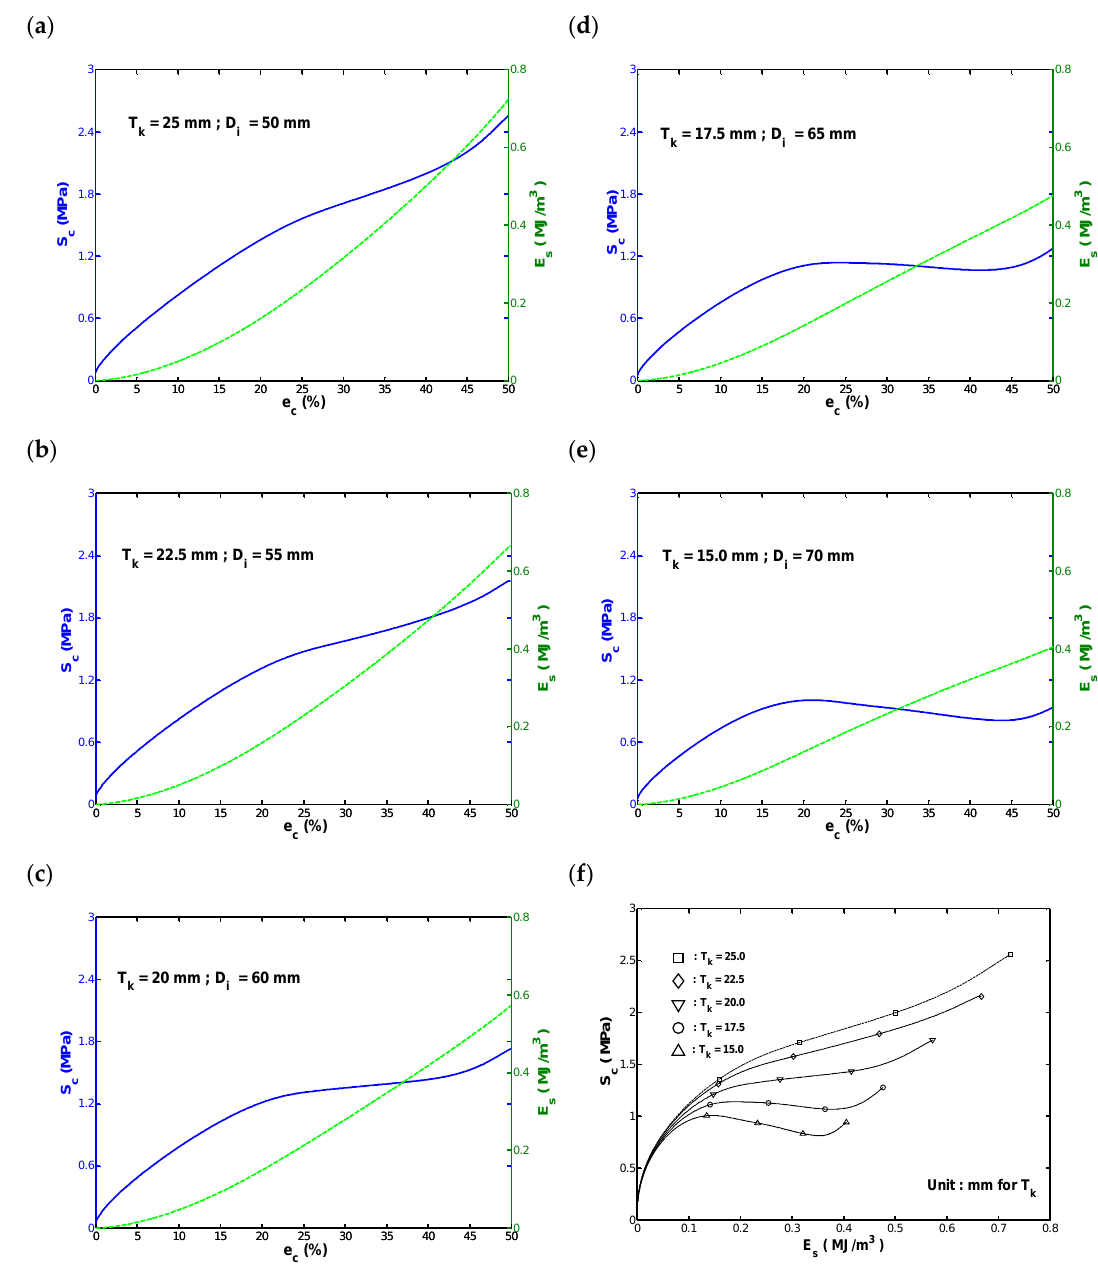
Figure 3. Monotonic compressive responses of hollow-cylinder rubber fenders with wall thicknesses of: ( a ) 25.0, ( b ) 22.5, ( c ) 20.0, ( d ) 17.5, and ( e ) 15.0 mm. ( f ) Comparison of S c − E s curves for fenders with different wall-thicknesses.